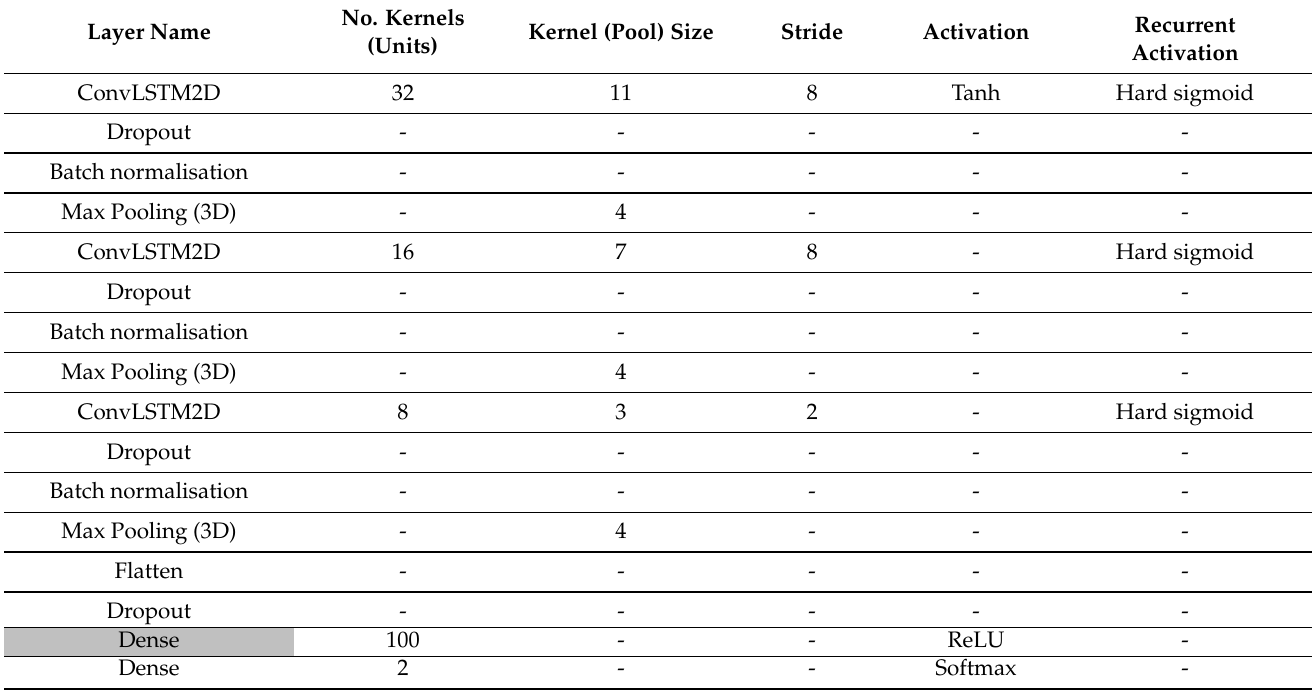
Table 4. The architecture that uses ConvLSTM blocks, later referred to as just ’LSTM’ with a drop rate set to 0.1. The ’re- turn_sequences’ parameter for the ConvLSTM layers was set to True.